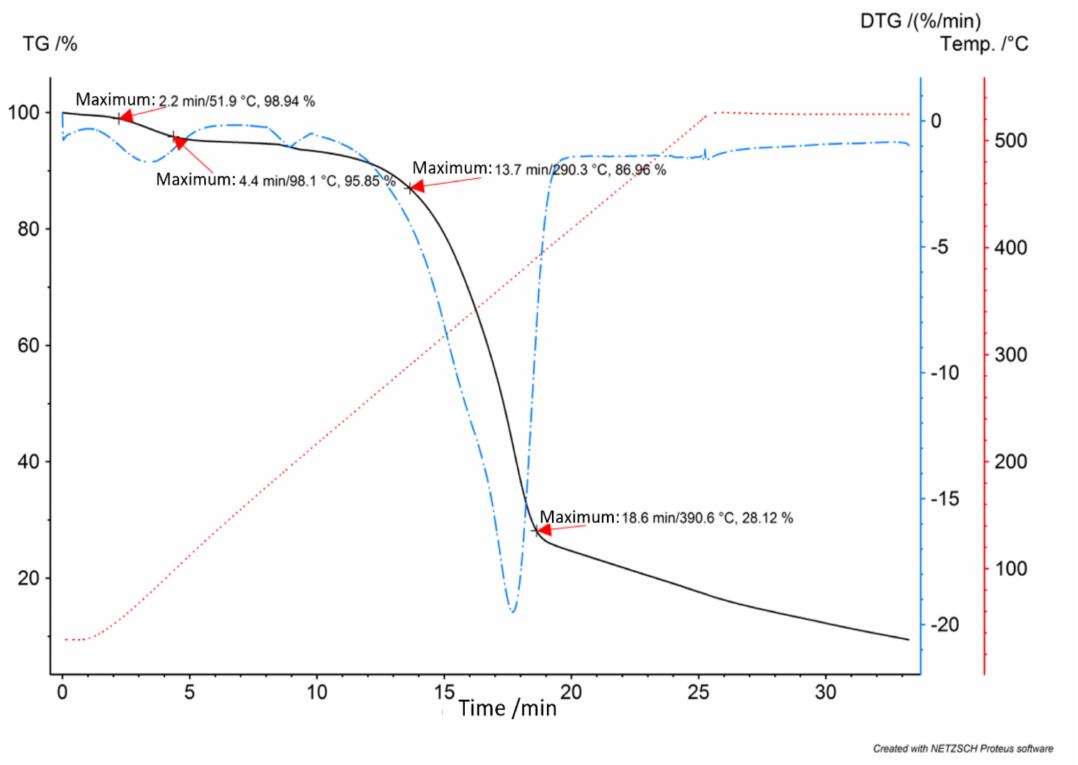
Figure 5. TGA analysis of pine wood and maximum mass loss